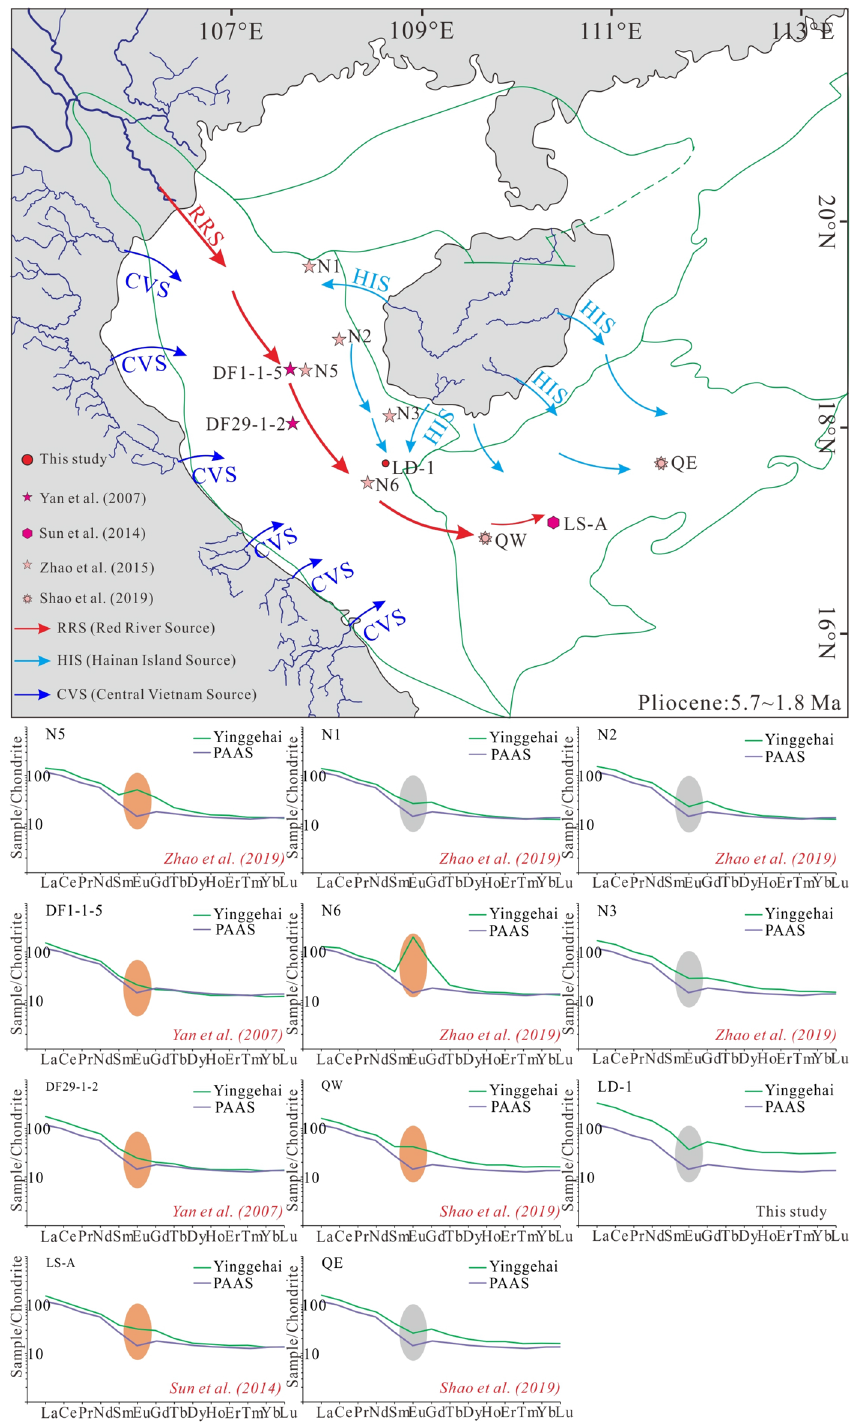
Figure 12. Schematic source-to-sink evolution model and chondrite 50 normalized REEpatterns of Pliocene samples from the Yinggehai and Qiongdongnan